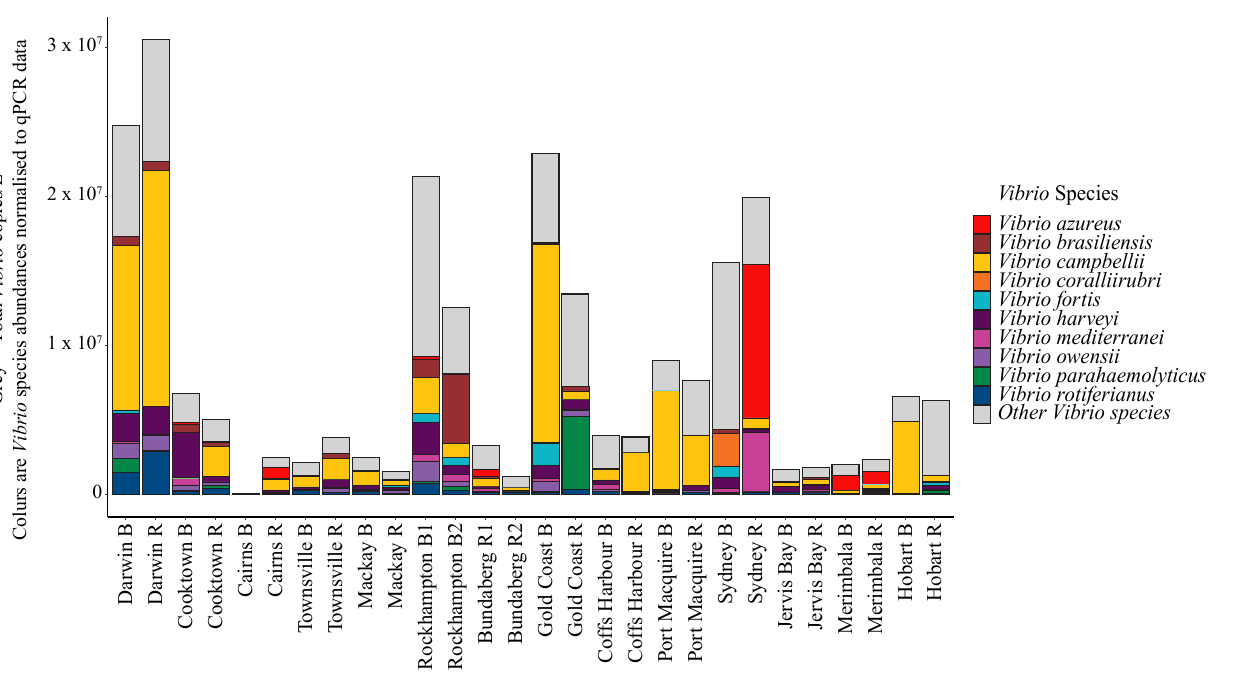
Figure 4. Stacked bar-plot of the top 10 most abundant Vibrio species from the hsp60 gene amplicon sequencing data along the East Coast of Australia. Data is normalised to the total Vibrio qPCR data